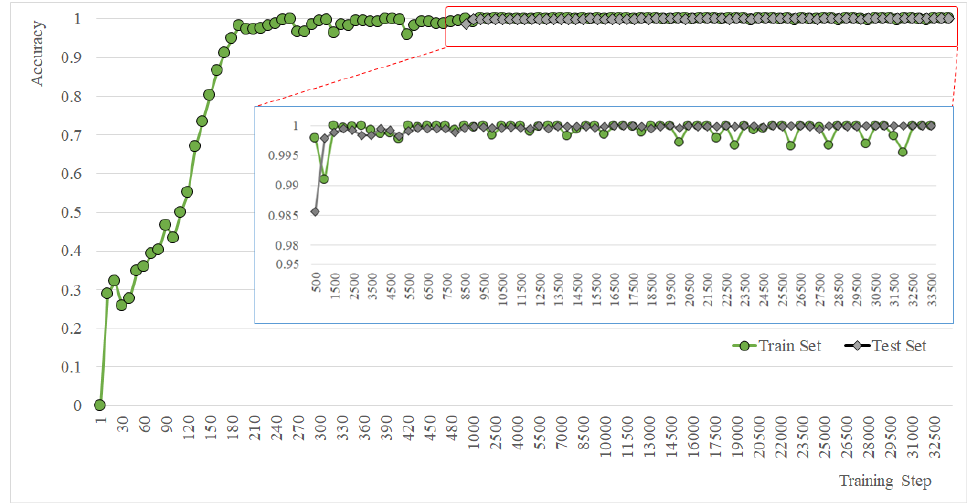
Figure 16. Accuracy of experiment 3 (four-class).